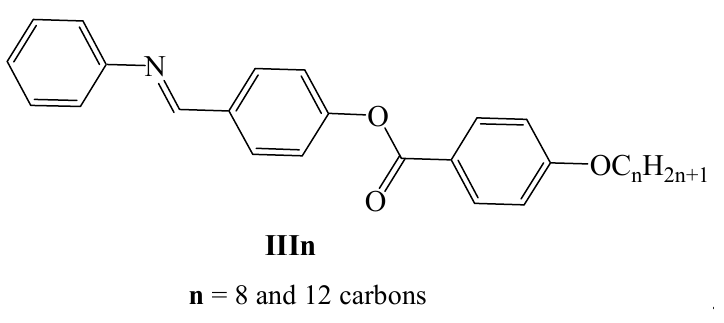
Figure 5. Molecular structures of IIIn series.